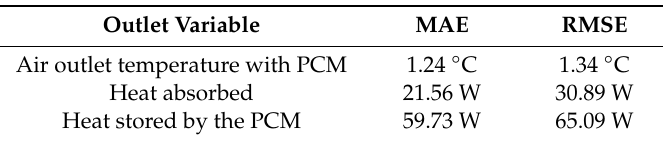
Table 4. Validation